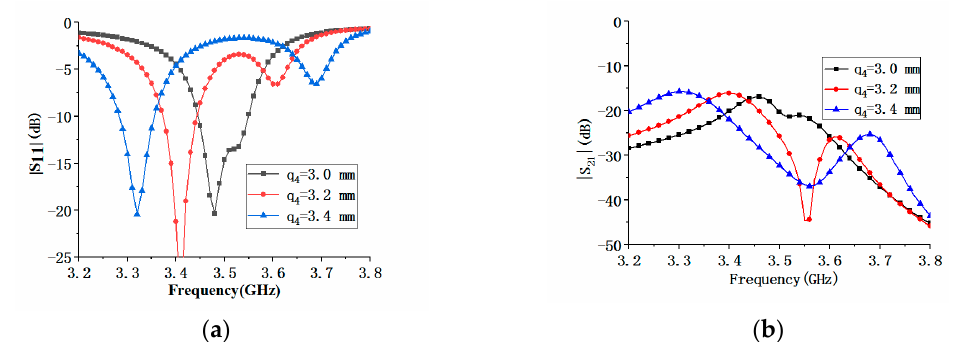
Figure 19. Comparison of | S 11 | and isolation of the proposed antenna with different antenna parameter q 4 : ( a ) | S 11 | comparison; ( b ) |S 21 | comparison.